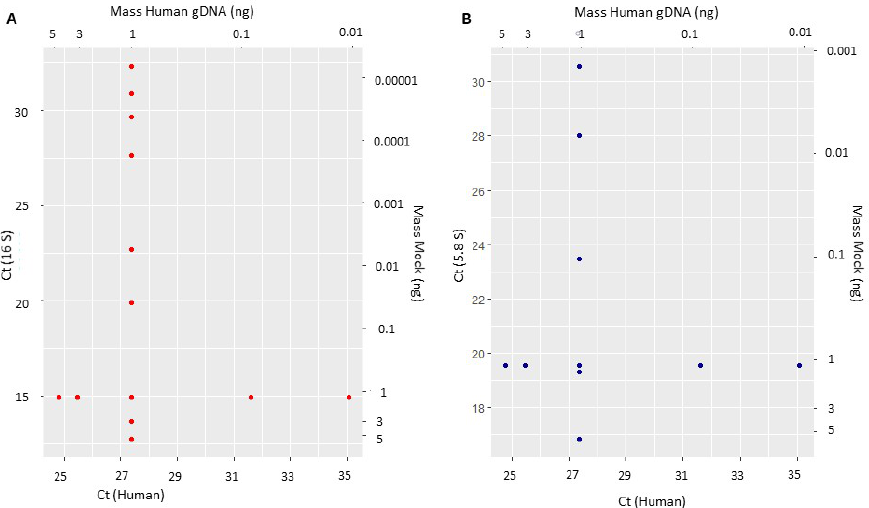
Figure 2. Effects of varying DNA mass over amplification capabilities of bacteria ( A ) and fungi ( B ), as compared to human DNA amounts. Horizontal axes indicate the Ct value for human DNA and vertical axes indicate Cts for bacteria (16S) or fungi (5.8S). Each dot represents the mean of a triplicate experiment.